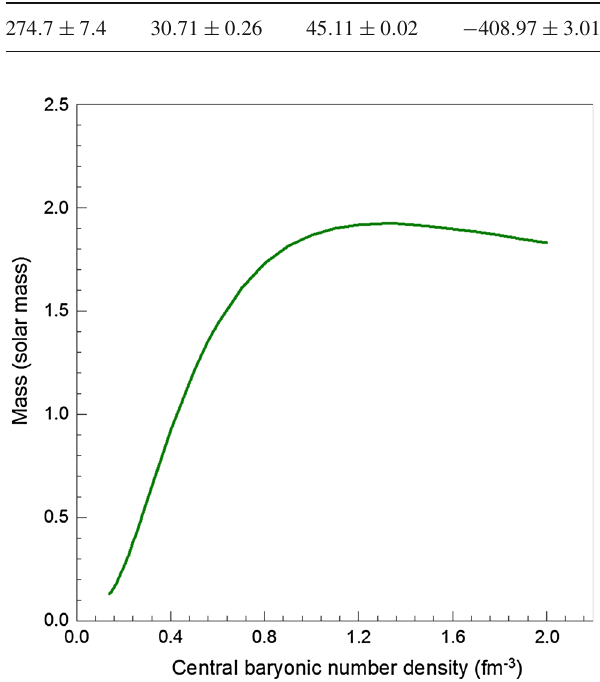
DDM3Y EoS. The maximum mass goes to 1 . 9227 M (cid:3) with a radius of 9.7559 km [51–53].